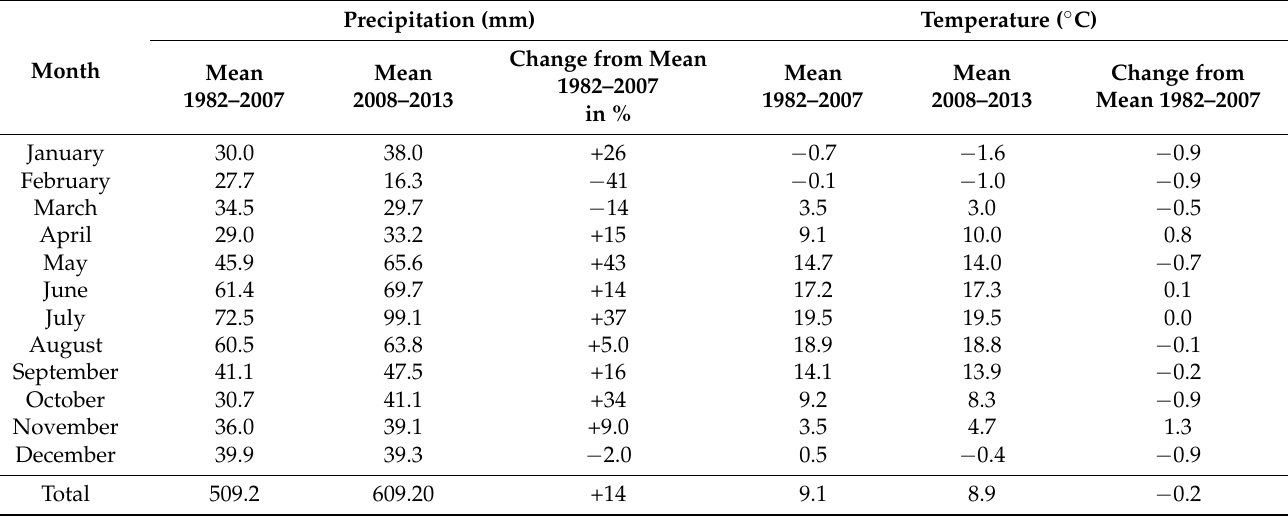
Table 2. Meteorological conditions in